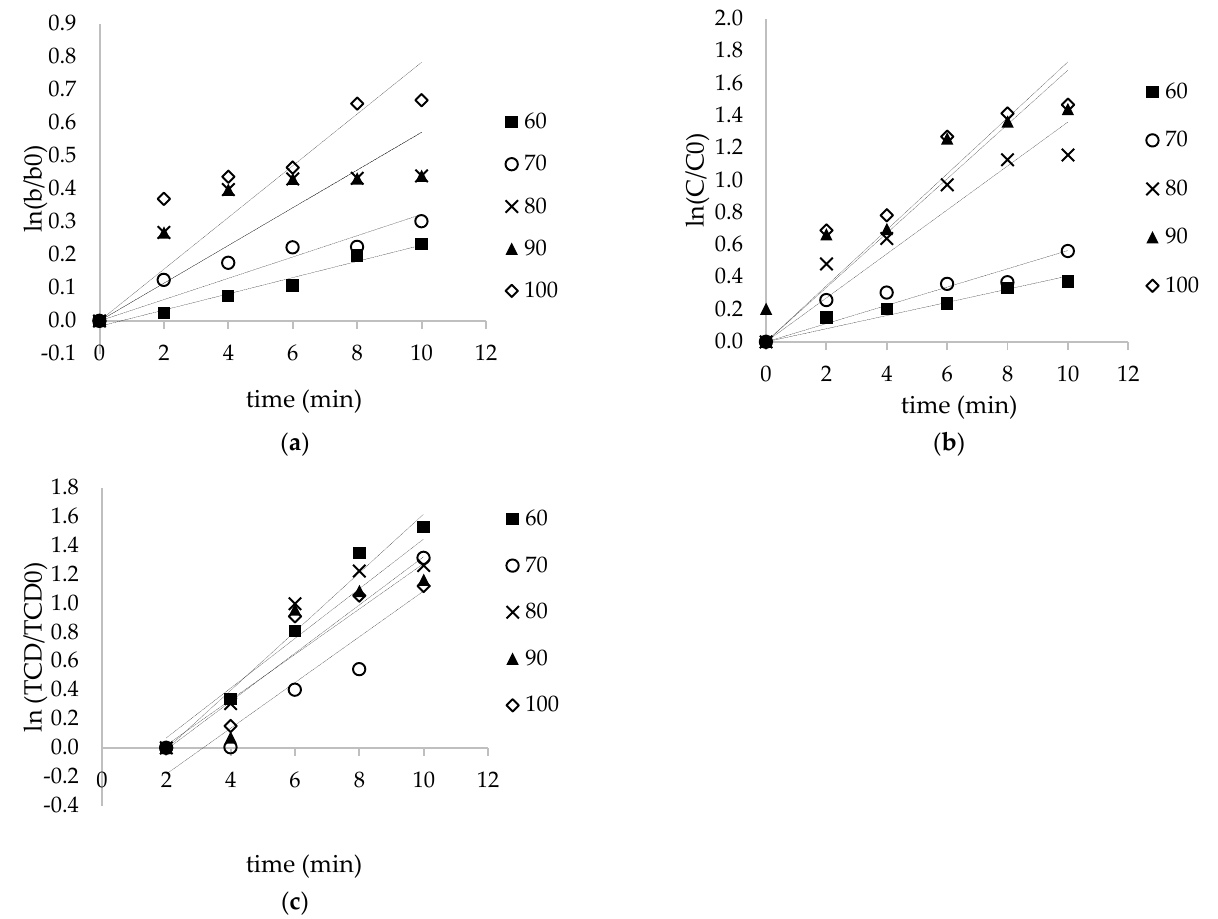
Figure 3. First-order kinetic model of the effect of blanching (60, 70, 80, 90 and 100 ° C) on the color parameters of Dabai fruit: ( a ) b *, ( b ) chroma, and ( c ) TDC . Table 1. The reaction rate (k) and coefficient of determination (R 2 ) of the zero-order kinetic model, first-order kinetic model and fractional conversion order kinetic model of changes of color parameter ( a *, b *, C and TCD ) of Dabai fruit, due to